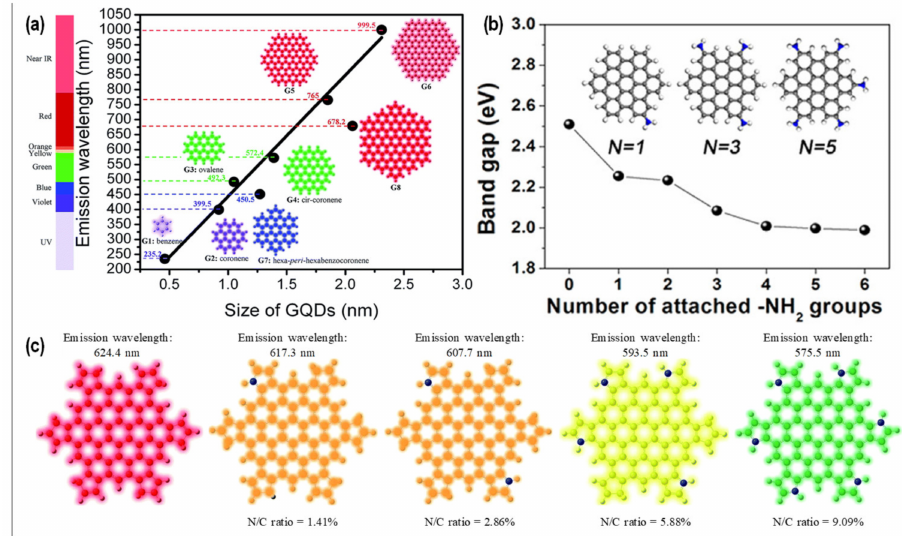
Figure 2. Tunable-emission GQDs induced with bandgap alteration. Emission-controlled GQDs via ( a ) size modification [7], ( b ) surface functionalization [28], and ( c ) heteroatom doping